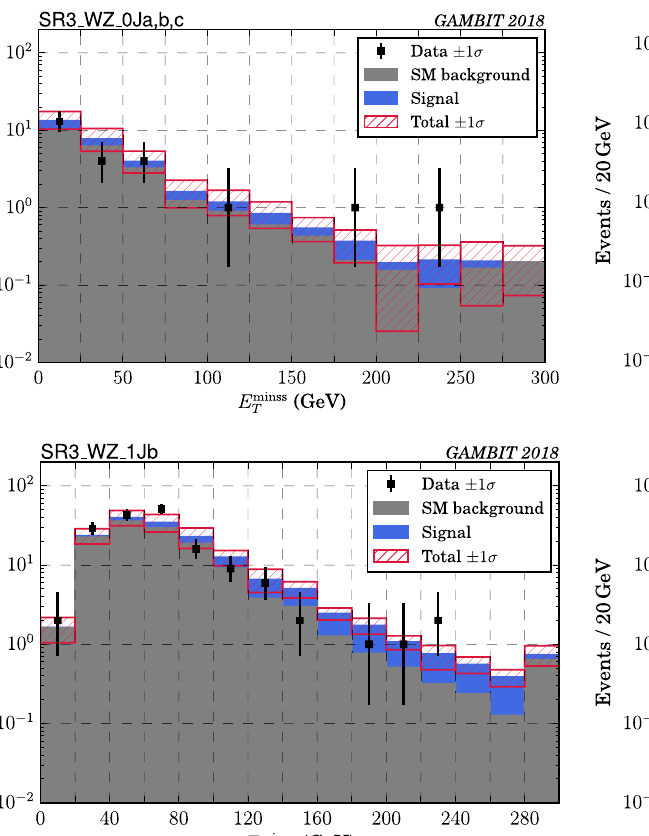
The hatched red bands show the 1 σ uncertainty on the total number of expected events, found by summing in quadrature the background uncertainty and the signal statistical uncertainty for our best-fit point. The black points show the ATLAS